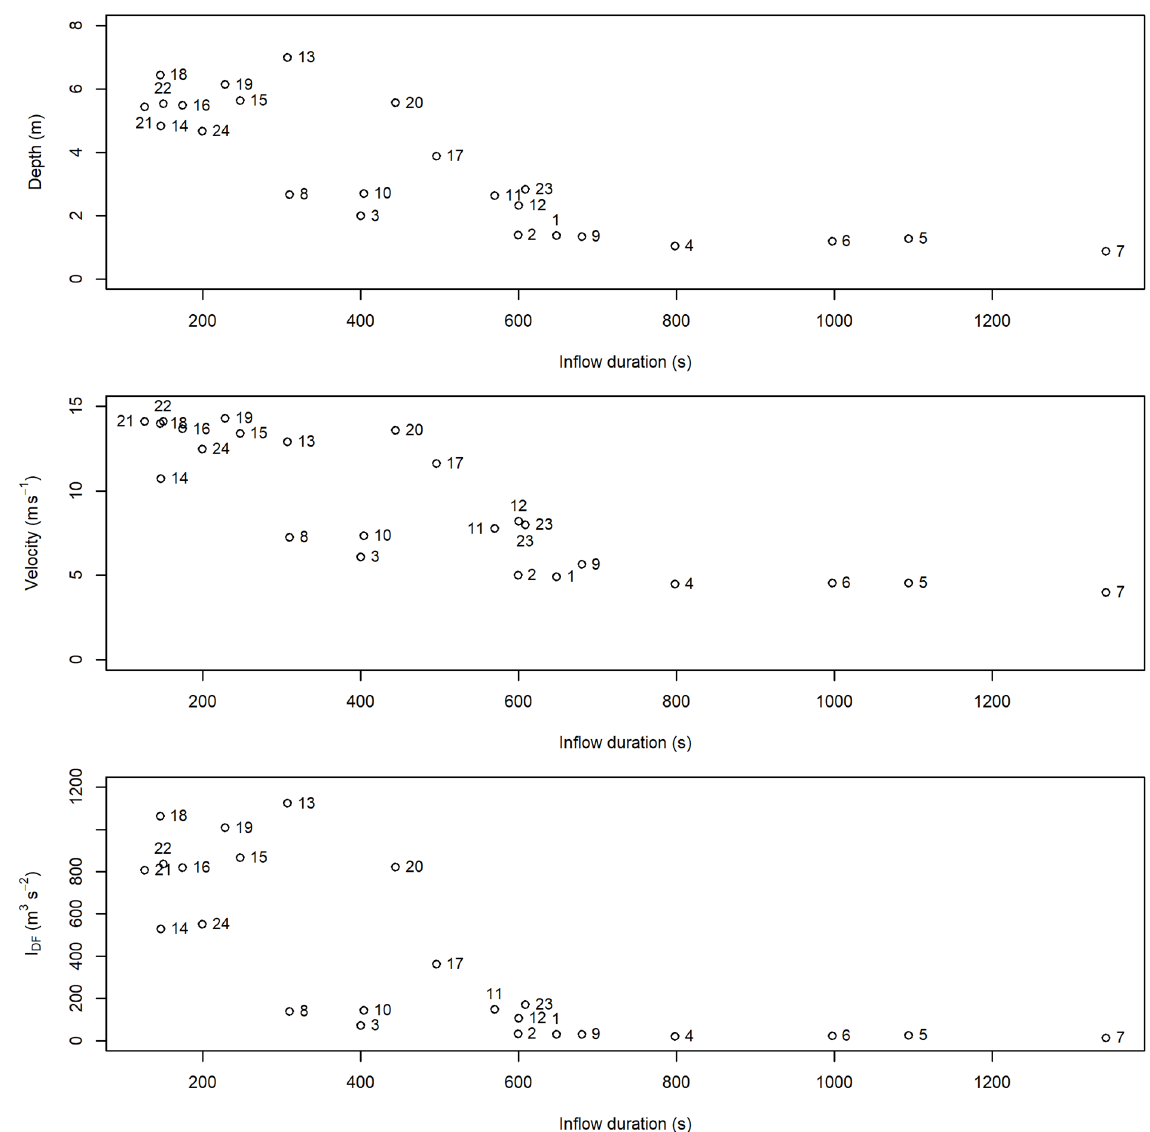
Figure A7. Relationships between input hydrograph inflow duration and flow depth, velocity, and I DF for the numerical flume at x = 1000m. The numbers correspond to the hydrograph IDs summarized in Table